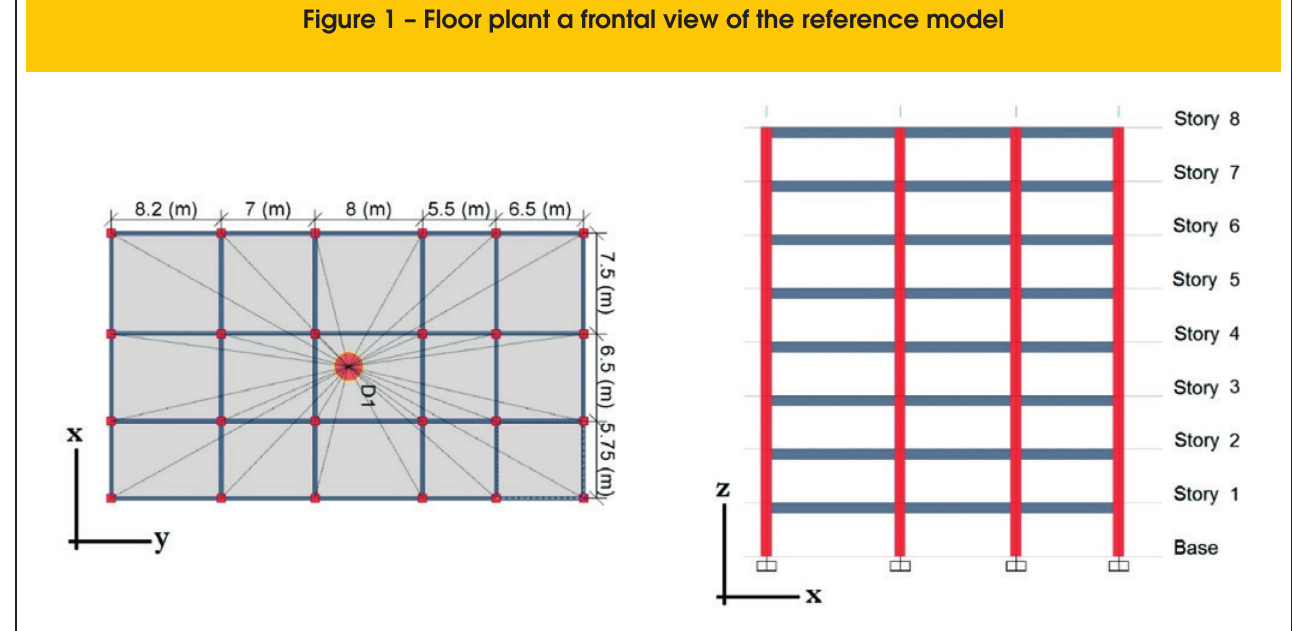
Figure 1 – Floor plant a frontal view of the reference